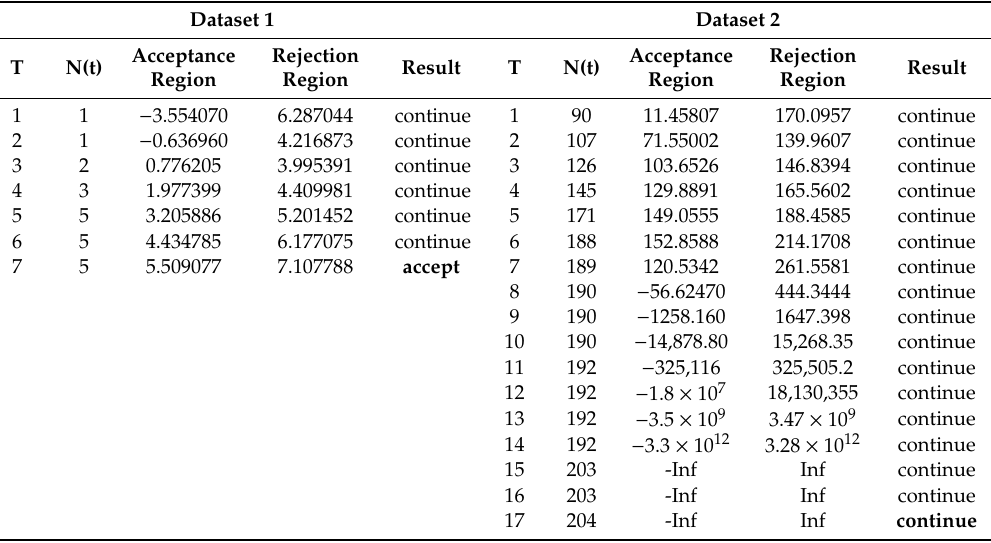
Table 11. SPRT results for both datasets (Case 2, parameter